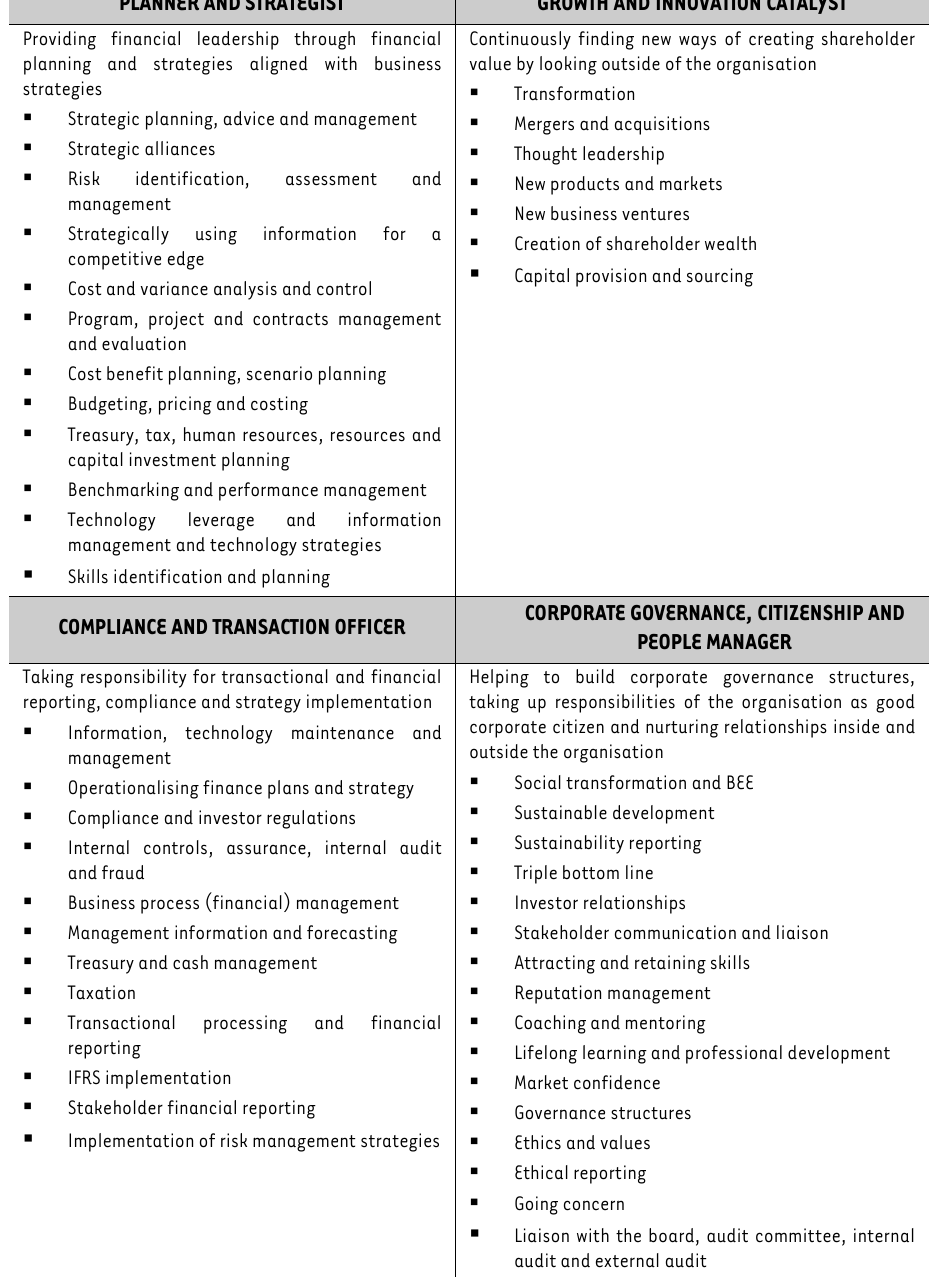
TABLE 1: A South African model of the key focus areas of CFOs PLANNER AND STRATEGIST GROWTH AND INNOVATION